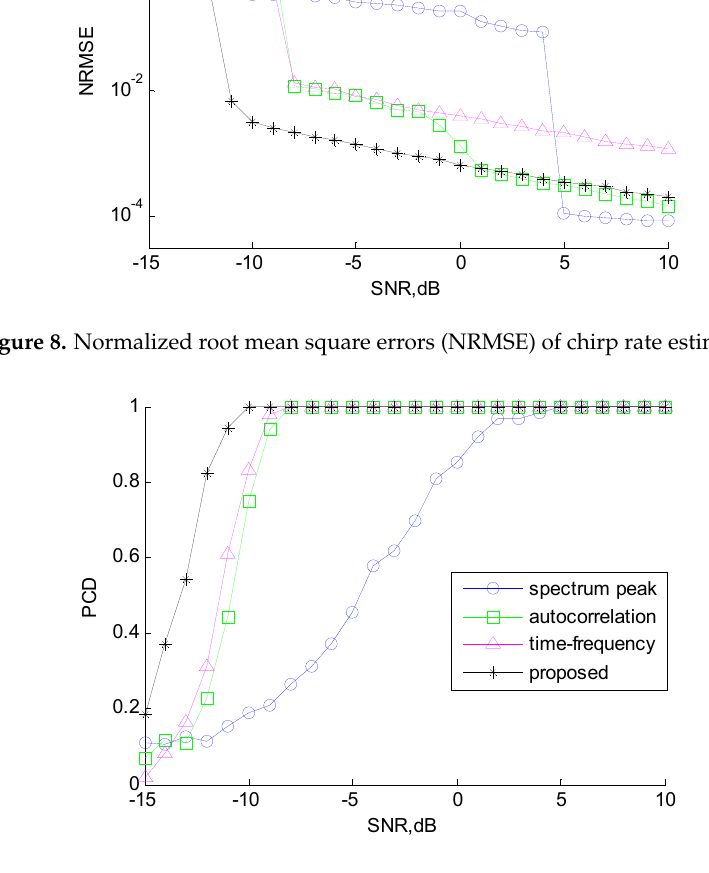
Figure 9. Correct ratio of Nyquist Zone (NZ) index estimation.